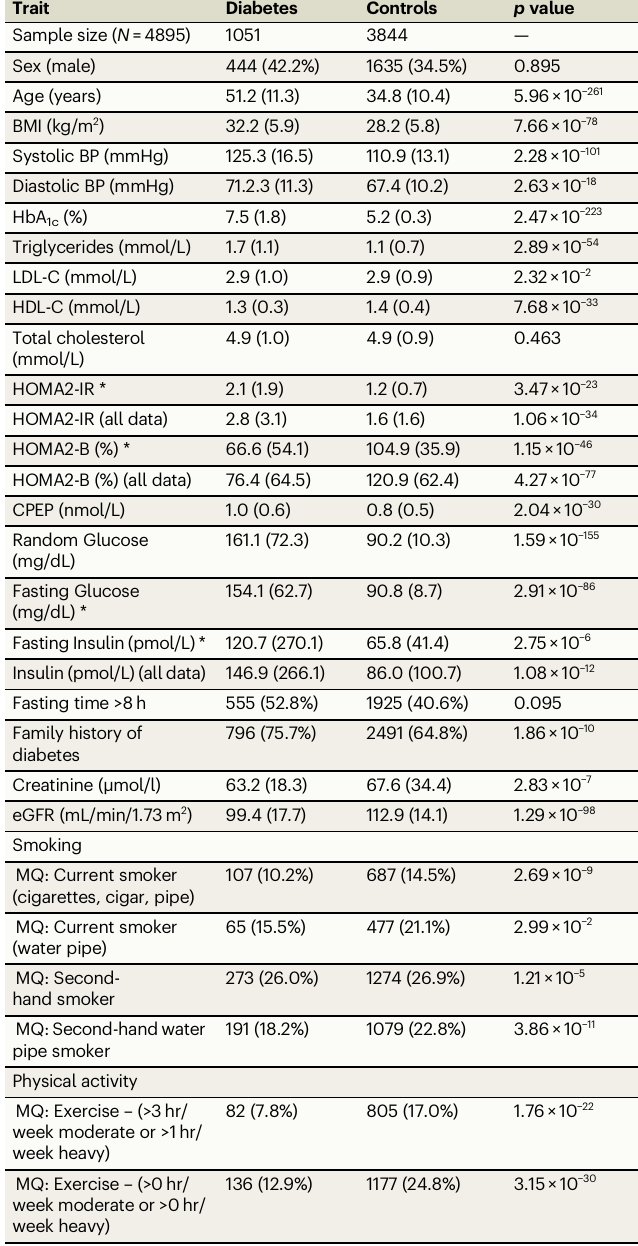
Table 1 | Demographics of the QBB diabetes and control groups